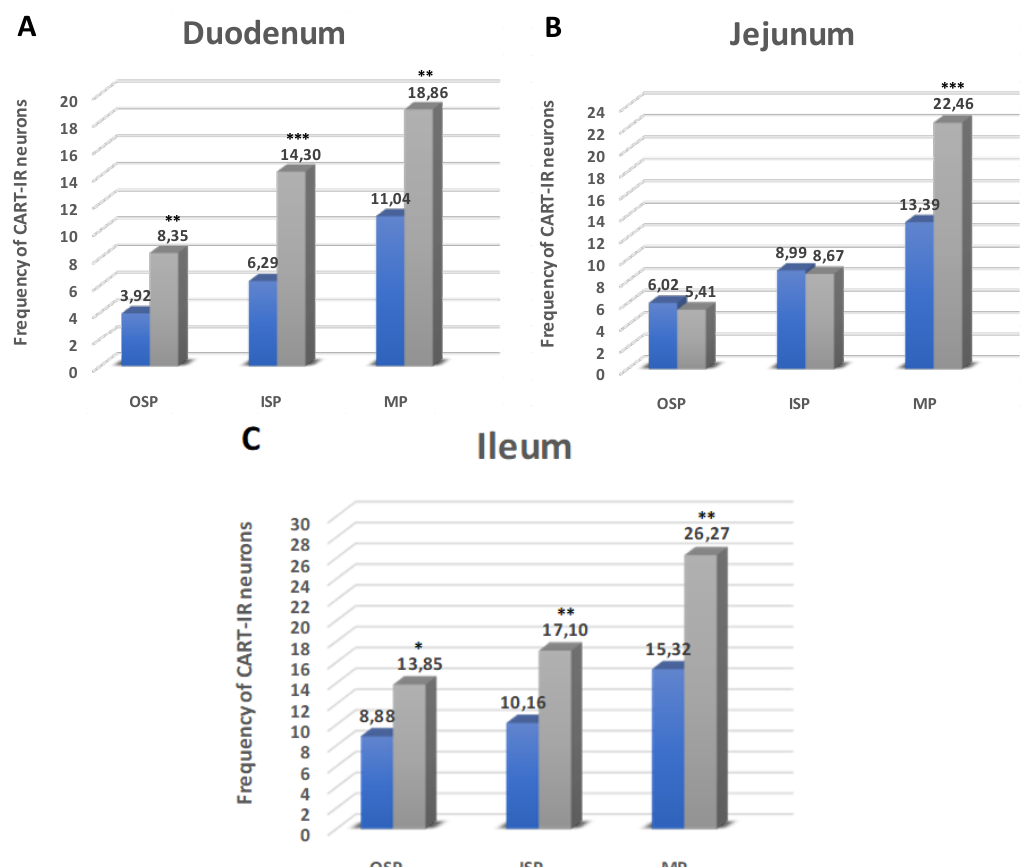
Figure 1. Diagram of the numbers of perikarya immunoreactive to Cocaine- and amphetamine-regulated transcript (CART) ( A–C ) of the control (blue bars) and experimental group (grey bars) in the particular parts of the small intestine. OSP – outer submucosal plexus, ISP – inner submucosal plexus, MP – myenteric plexus. * p < 0.05, ** p < 0.01, *** p < 0.001 – indicate differences between all groups for the same neuronal populations.